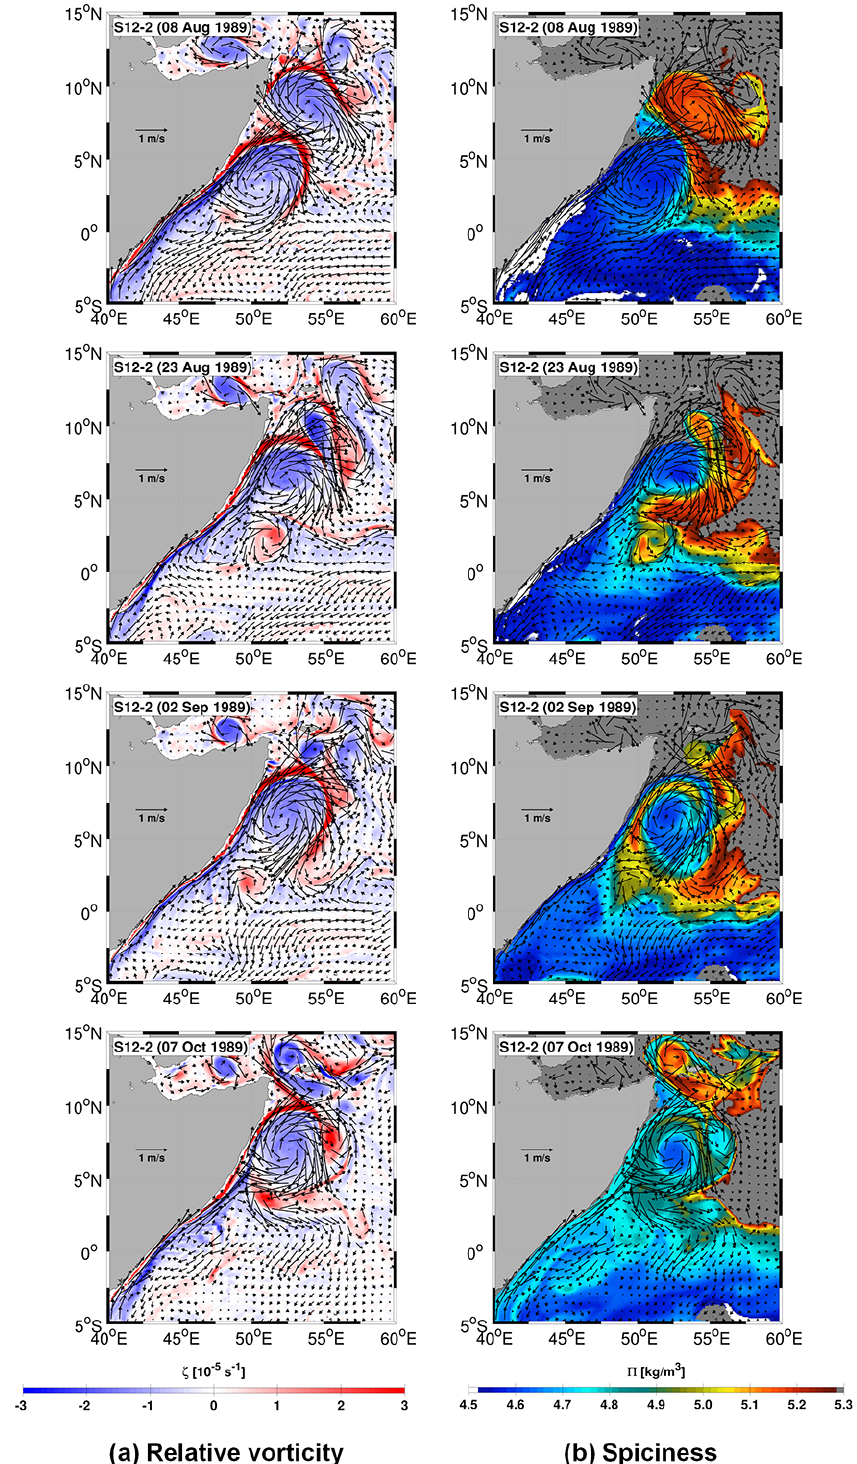
Figure 6. Snapshots of current (vectors; ms − 1 ) at 50m superimposed on (a) relative vorticity ( ζ ; colour shading; s − 1 ) at 50m and (b) spici- ness on isopycnal σ 0 = 23.8 ( (cid:53) ; colour shading; kgm − 3 ), between August and October 1989 in the 1 / 12 ◦ S12-2